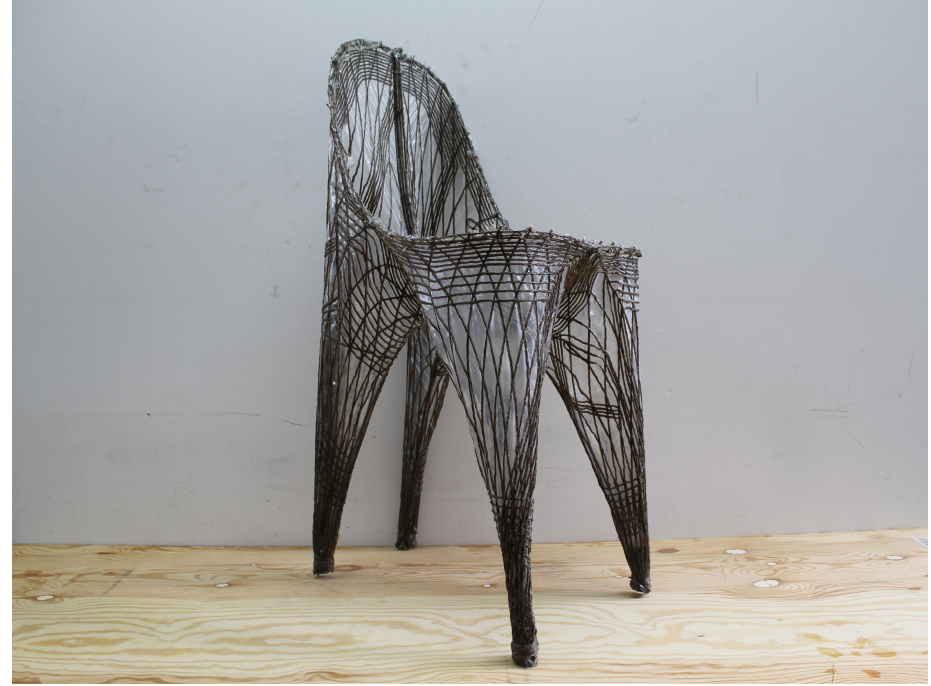
Figure 25. Second prototype fabricated with automated Tailored Fibre Placement (TFP)